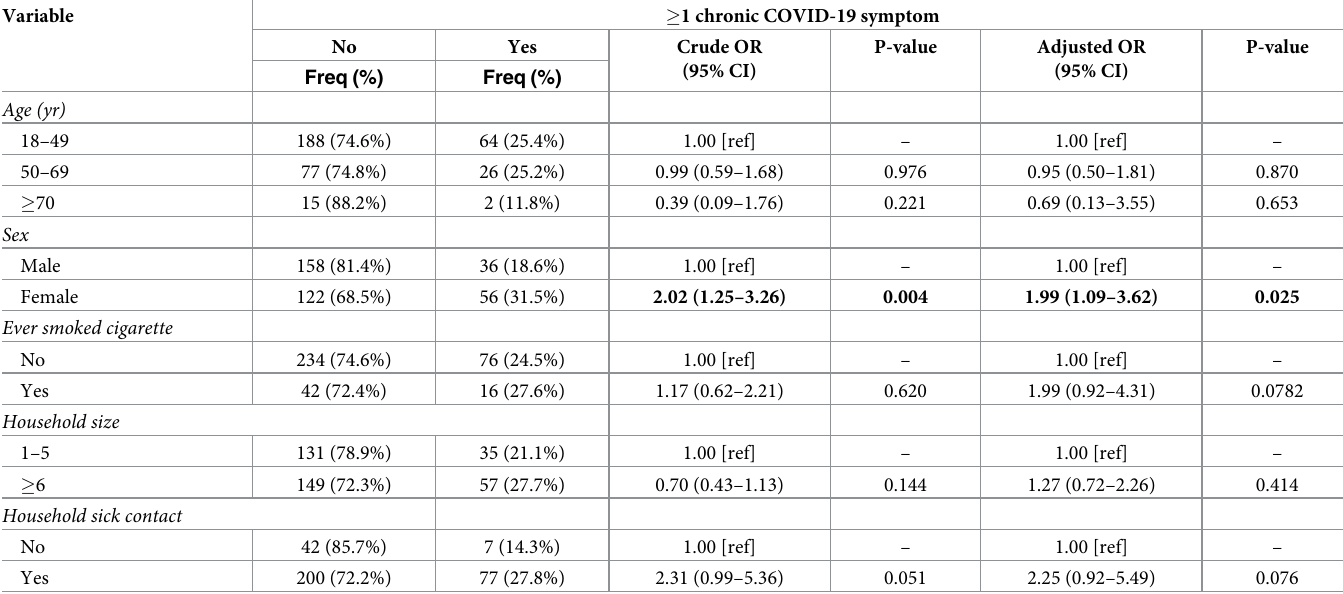
Table 2. Associations of having one or more chronic COVID-19